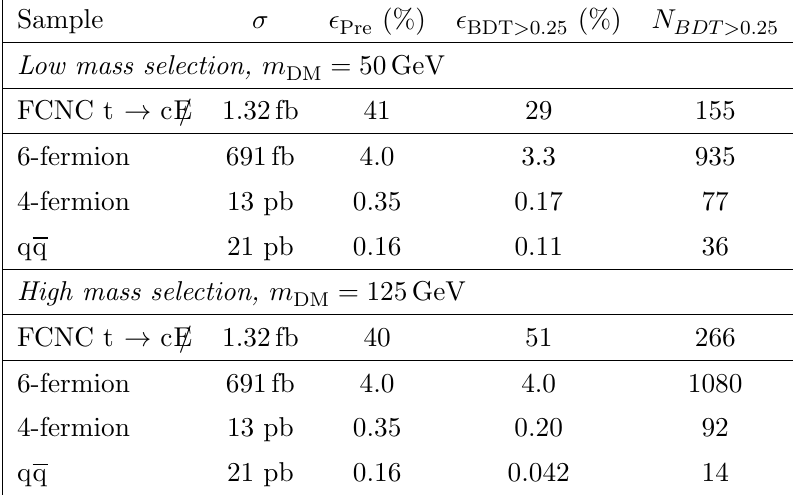
, of 50 GeV (upper part of the DM ) and the Pre